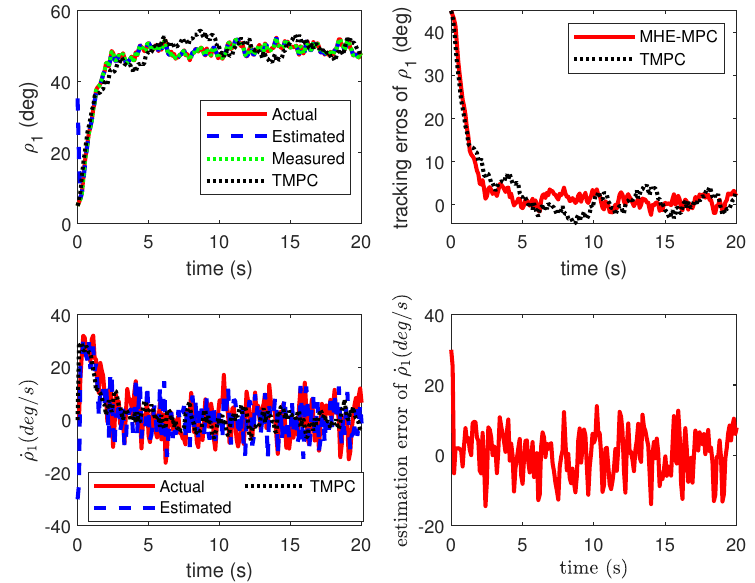
Figure 8. Case 2: state variables ρ 1 , ˙ ρ 1 and their tracking/estimation